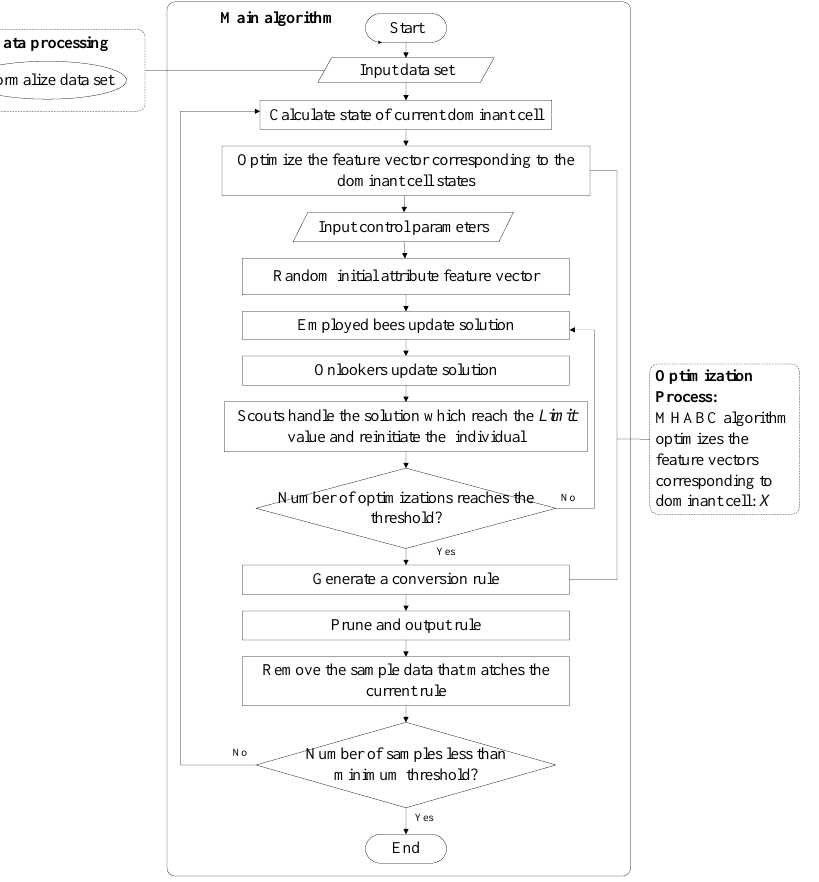
Figure 3. Flow chart of the improved hybrid artificial bee colony algorithm based on the mutation of inferior solutions (MHABC)-CA algorithm.